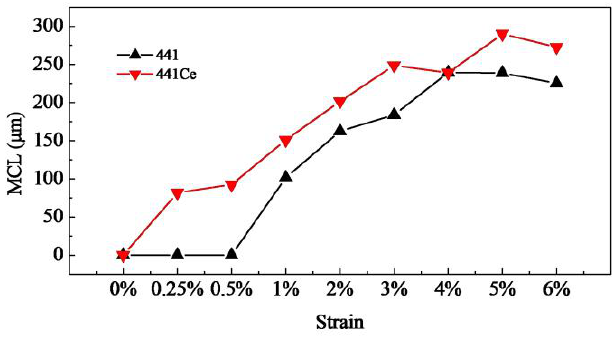
Figure 2. MCLs of the test materials under various strains.